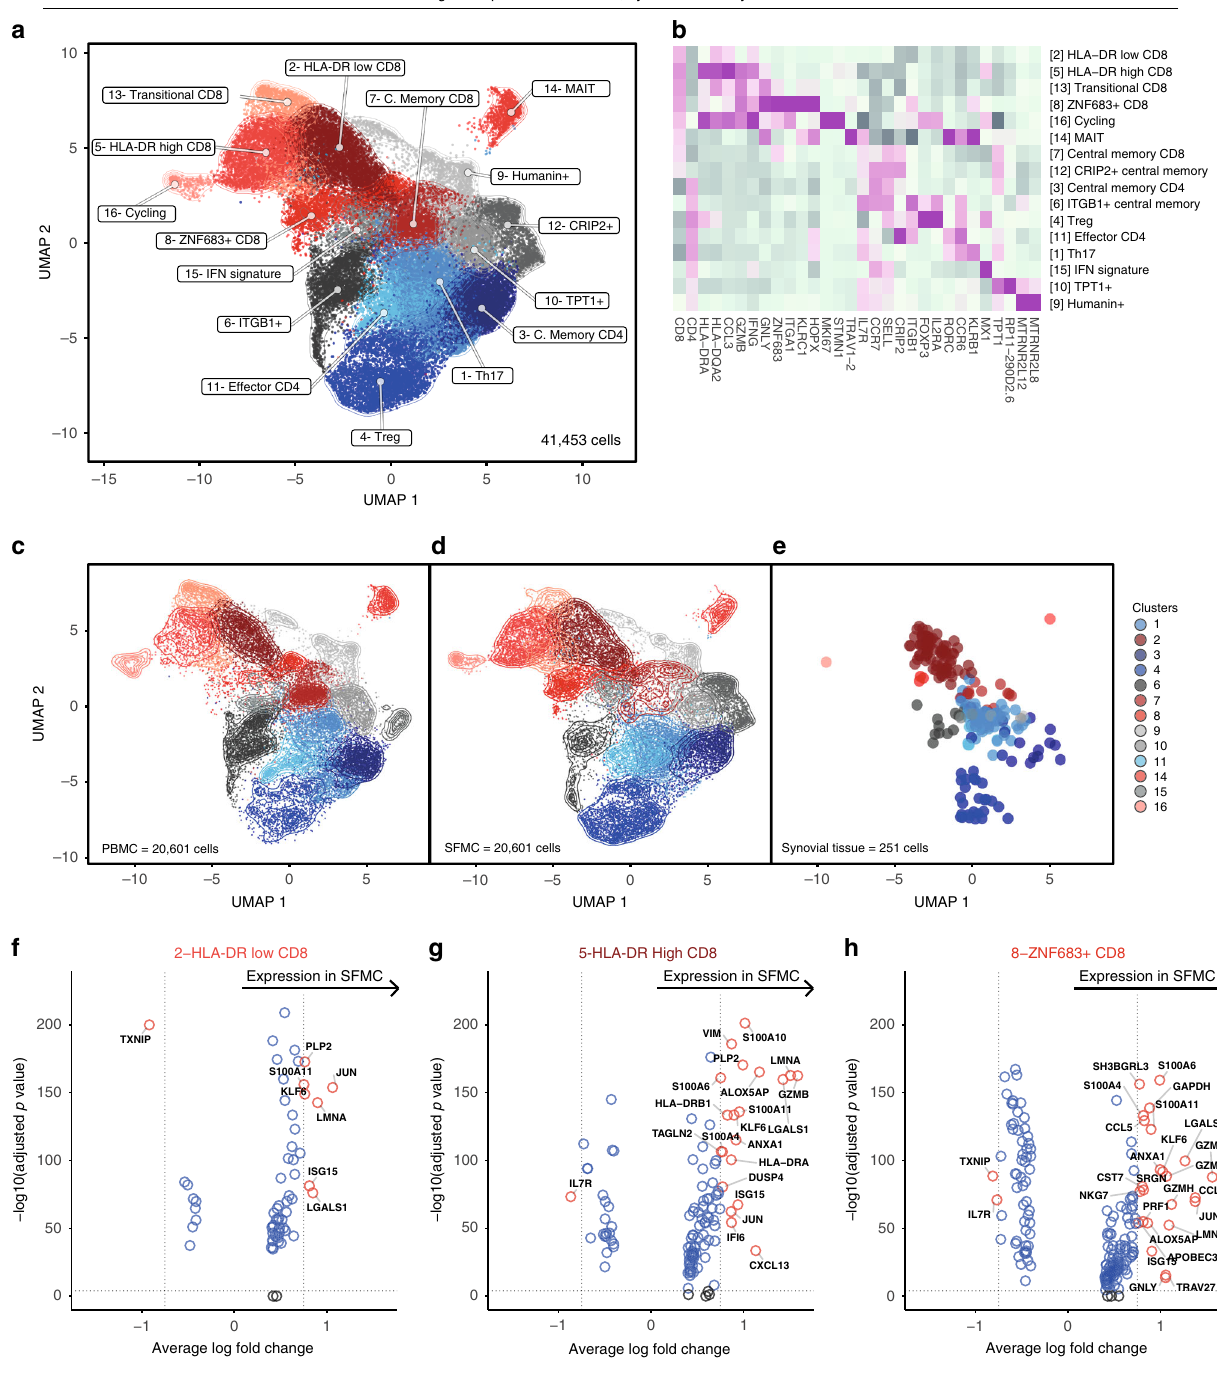
Fig. 2 Transcriptional landscape of CD4 and CD8 T cells in psoriatic arthritis. a UMAP of integrated PsA blood, synovial fl uid and synovial tissue memory CD4 and CD8 T cells (paired blood and synovial fl uid from three patients; synovial tissue from two other patients). Clusters coloured red comprise CD8 cells, clusters coloured blue are CD4 cells. Clusters in grey contain mixed CD4 and CD8 populations. b Heatmap showing memory CD4 and CD8 immune subset signatures. The relative expression of marker genes (columns) across cell clusters (rows) is shown. c – e UMAPs showing the contribution of PBMC, SFMC and synovial fl uid-derived T cells to the integrated UMAP from ( a ). f – h Volcano plots showing differential expression of genes between blood and synovial fl uid T cells in HLA-DR-low ( f ), HLA-DR-high ( g ) and ZNF683 + ( h ) clusters (Supplementary Data 3a – c). Statistics calculated using two-sided Wilcoxon Rank Sum test with Bonferroni correction. Genes where adjusted p value < = 1E − 04 and average logFC is greater than 0.75 or less than − 0.75 are labelled and shown as red circles. Dotted lines indicate signi fi cance and average logFC cut-off for displaying labelled genes (paired blood and synovial fl uid from three patients). Source data are provided as a Source Data fi